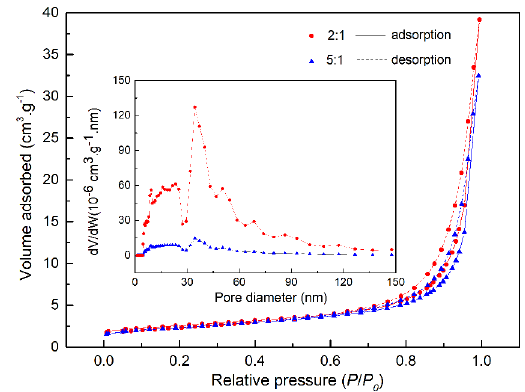
Figure 4. Nitrogen sorption isotherms and pore size distributions of samples synthesized with different salt